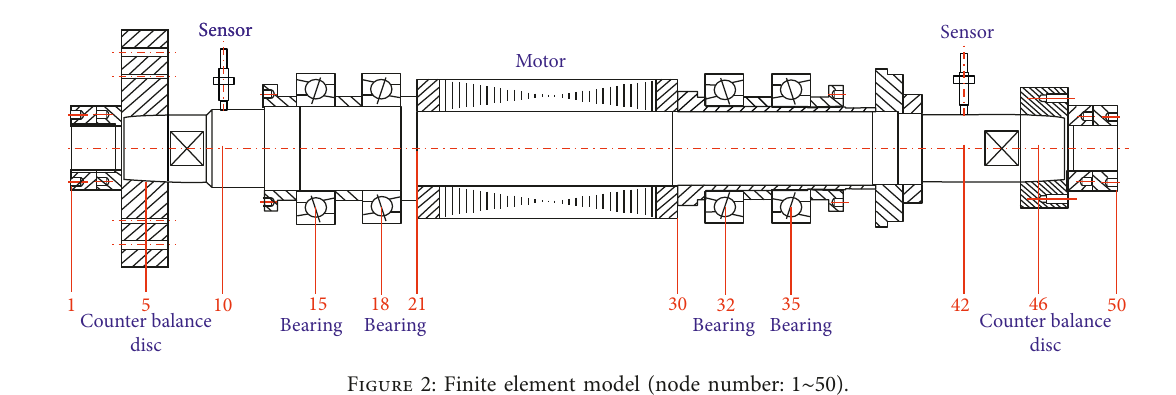
Figure 2: Finite element model (node number: 1 ∼ 50).